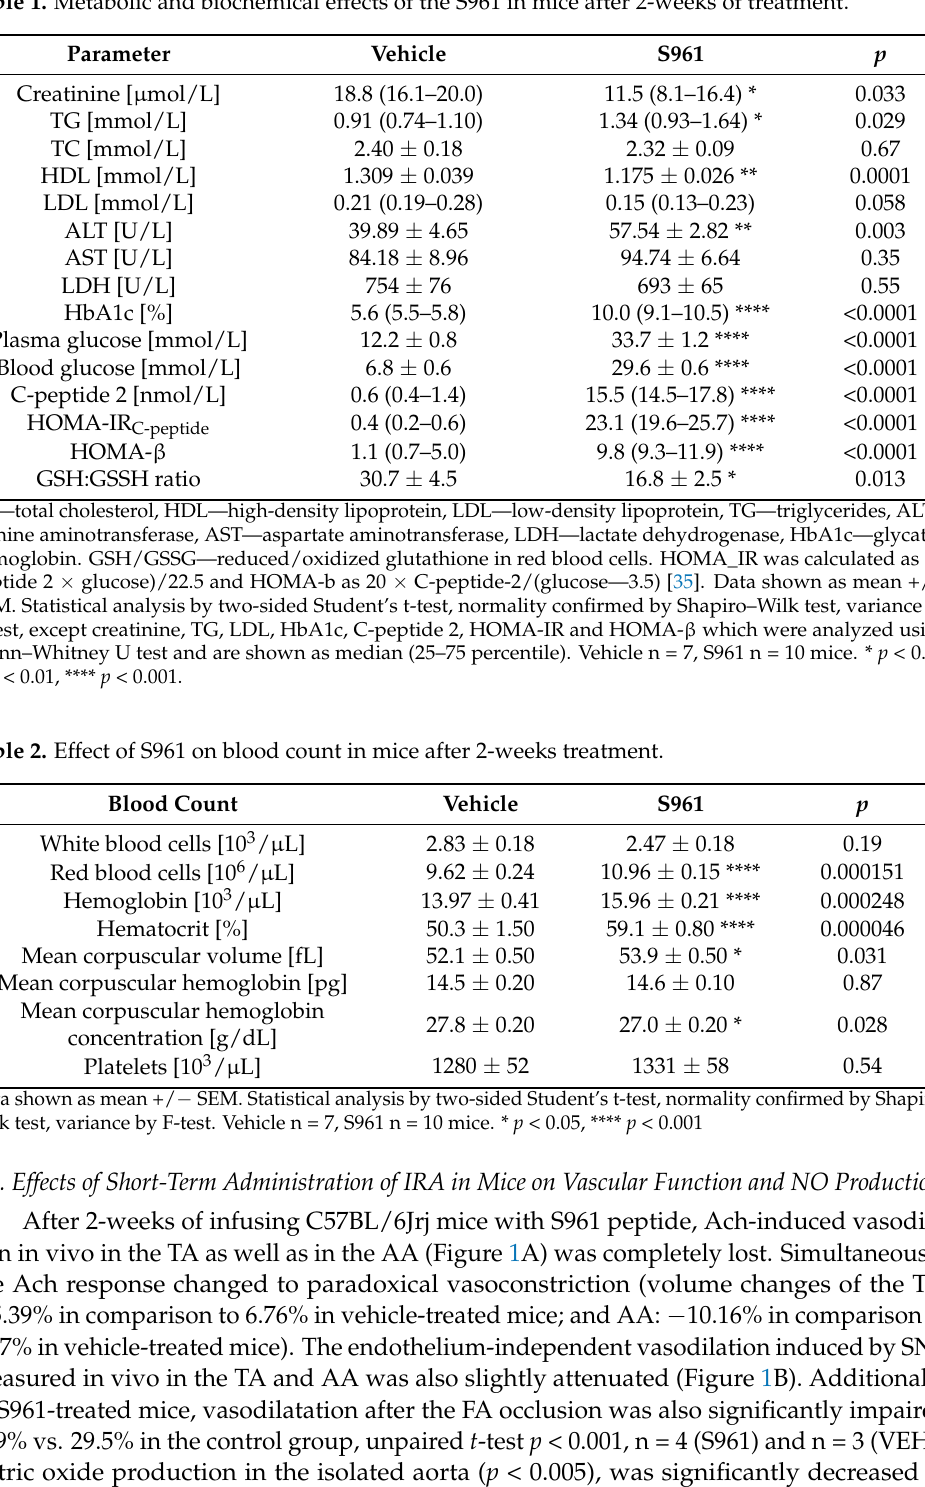
Table 1. Metabolic and biochemical effects of the S961 in mice after 2-weeks of treatment.